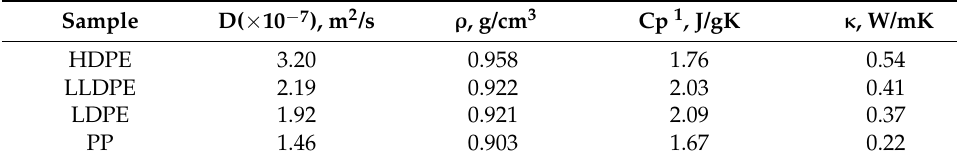
Table 2. D, κ , ρ , and Cp of HDPE, LLDPE, LDPE, and